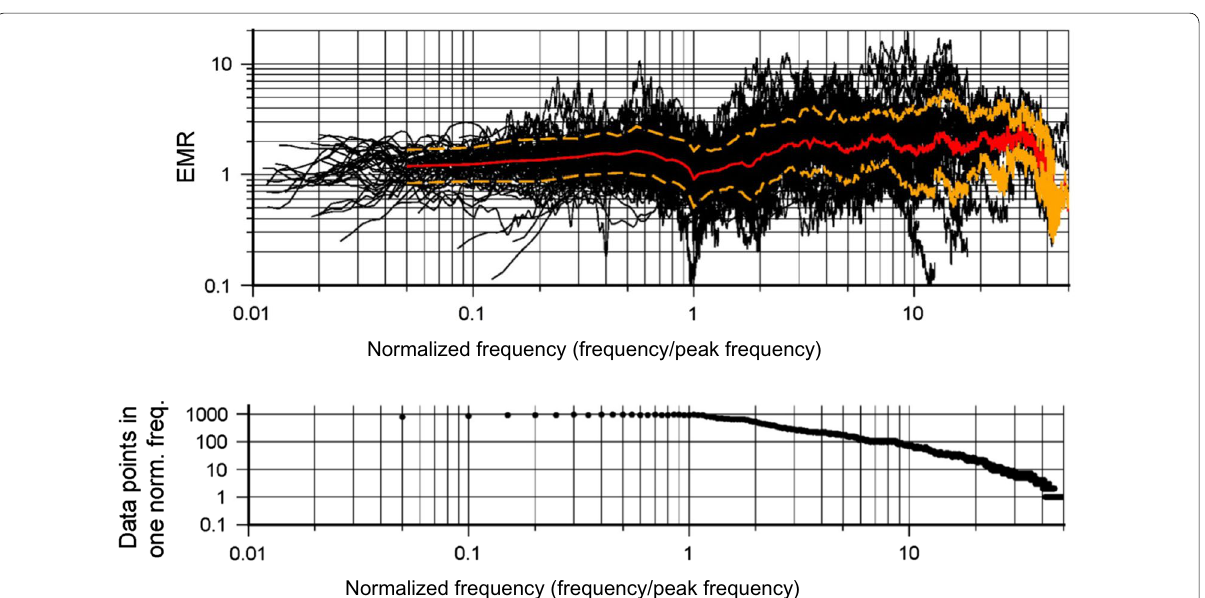
Fig. 10 Averaged EMR (red), the average one standard deviation (orange), and individual EMRs (black) where the horizontal axis at all the sites ± are normalized with respect to their fundamental peak frequencies of MHVRs. The lower panel shows the numbers of data used for averaging at each normalized frequency (with respect to the peak frequency) with the equal increment of 0.05. Since many frequency points will be provided from the sites with high fundamental peak frequencies, numbers below 1 are much